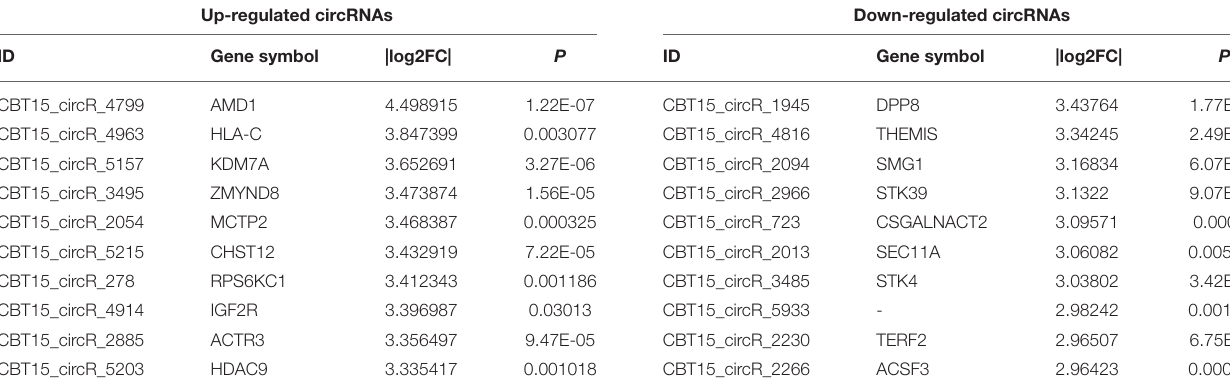
TABLE 3 | Top 10 of differently expressed circRNAs in HT and non-HT group.